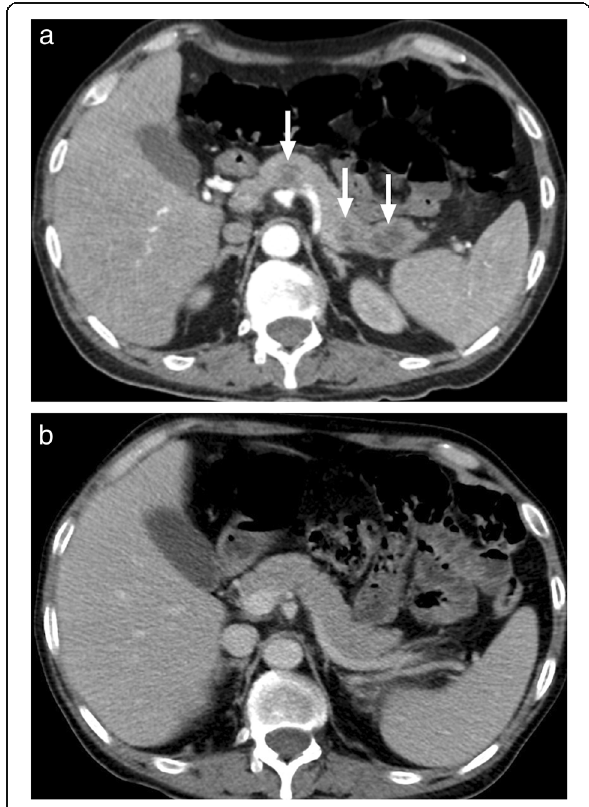
Fig. 30 A 65-year-old male with newly diagnosed aggressive lymphoma, undergoing intense chemotherapy in intensive care unit, recently started to complain of fever and epigastric pain. Blood tests were positive for leukocytosis and mildly elevated amylase. a Axial plane postcontrast abdominal CT image demonstrates several ill- defined, hypodense lesions within the pancreatic parenchyma (arrows). There was no pancreatic duct dilation or any peripancreatic inflammation/collection. Chest CT study showed innumerable foci of septic emboli within the lung parenchyma. Pancreatic septic emboli or lymphomatous involvement of the pancreas were considered in differential diagnosis. b Follow-up abdominal CT 7 days after IV antibiotic treatment, surprisingly demonstrated almost